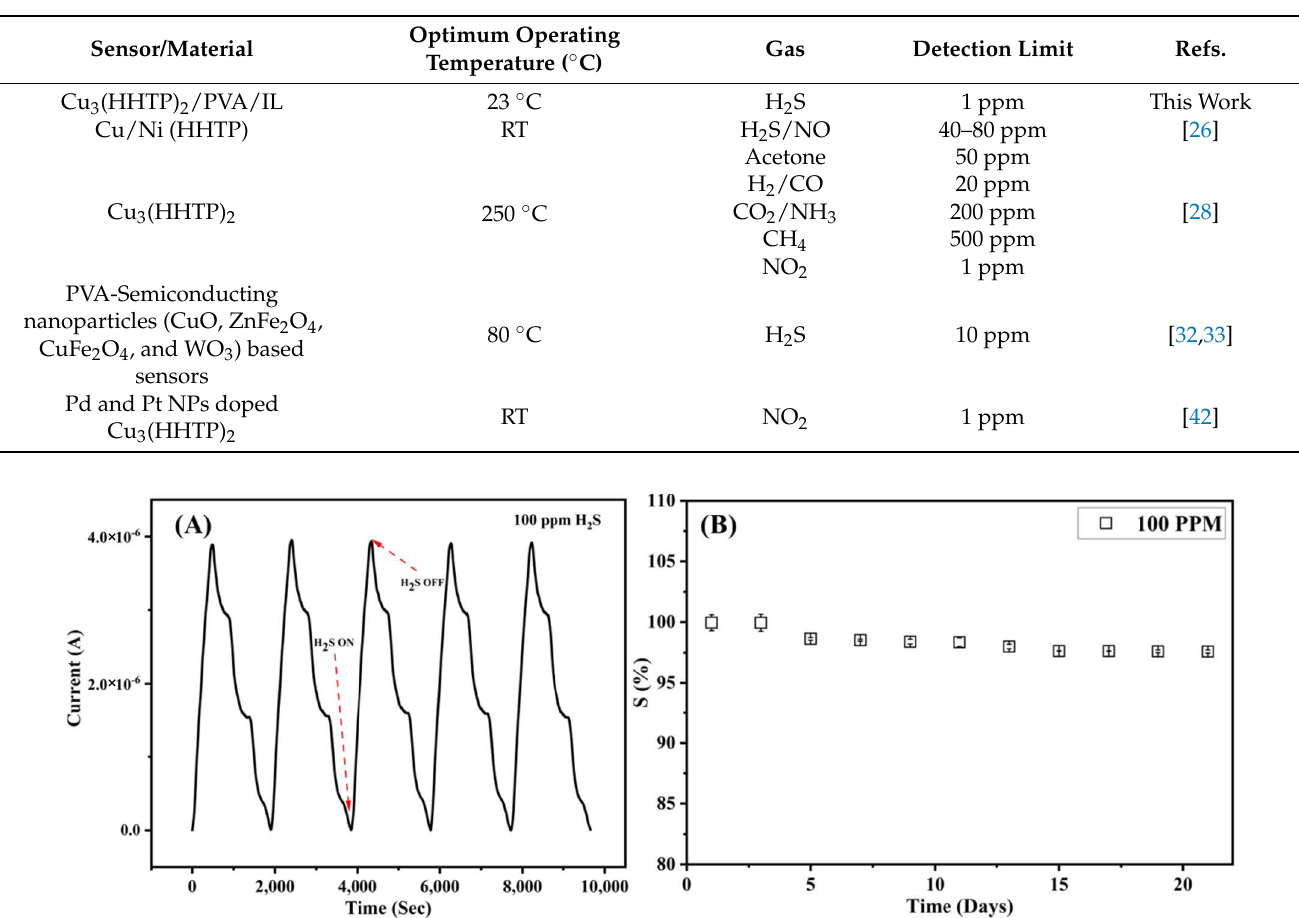
Figure 7. ( A ) Reproducibility of the Cu-MOF/PVA/IL membrane at RT. ( B ) Long-term stability performance of the Cu-MOF/PVA/IL sensor at RT for 21 days.